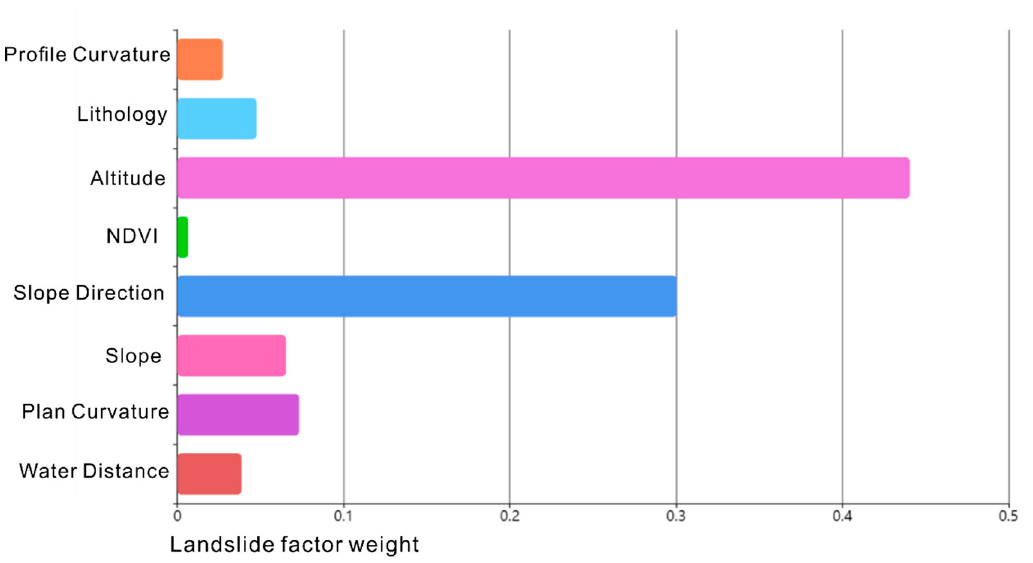
Figure 8. Environmental factor weight.